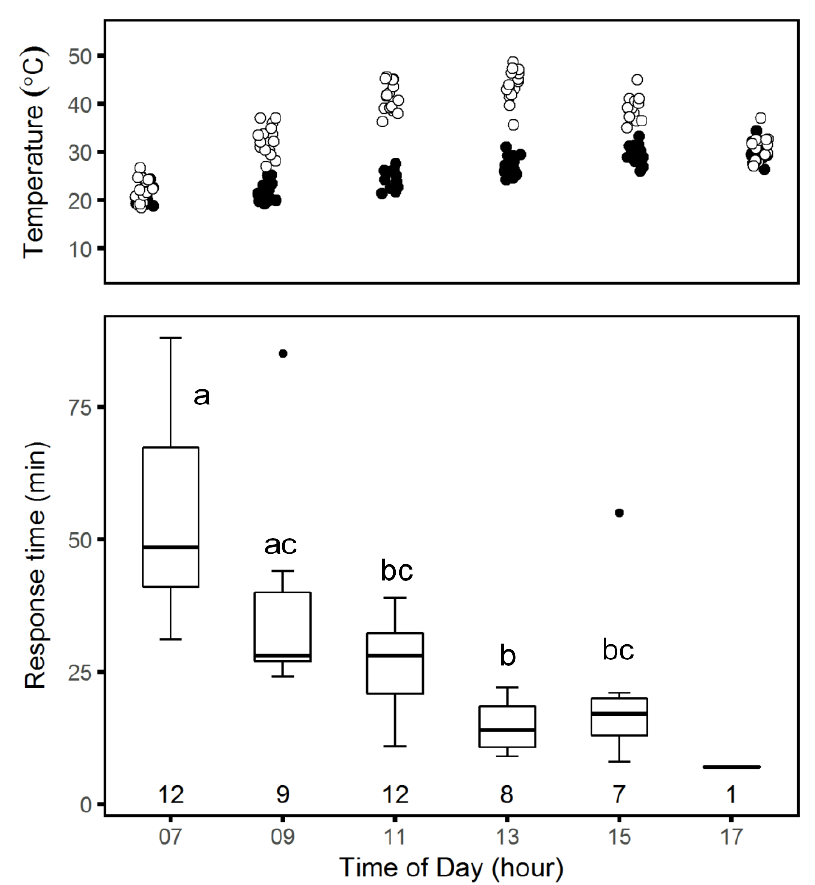
Figure 7. Soil temperatures ( top ) and boxplot of Lycosa hyraculus response times to trapdoor removal during the day ( bottom ). Soil surface temperatures (white) and temperatures at 100-millimeter depth (black) at the beginning of each trial were measured at the Jacob Blaustein Institutes for Desert Research meteorology station. Response time (t web,m ) was defined as the time in minutes from when we removed the trapdoor until the spider began spinning a mesh. Under each boxplot is the number of spiders, of the 15 observed, that spun meshes in that period. The thick horizontal line is the median, and the lower and upper hinges correspond to the 1st and 3rd quartiles. The whiskers extend to the farthest value within 1.5 times the inter-quartile range from the median. Any points beyond the whiskers are plotted individually as outliers. Bars with the same letters are not significantly different (Tukey’s post-hoc test, p < 0.05); t web,m is longest in the morning, but fewer spiders spin meshes in the late afternoon.